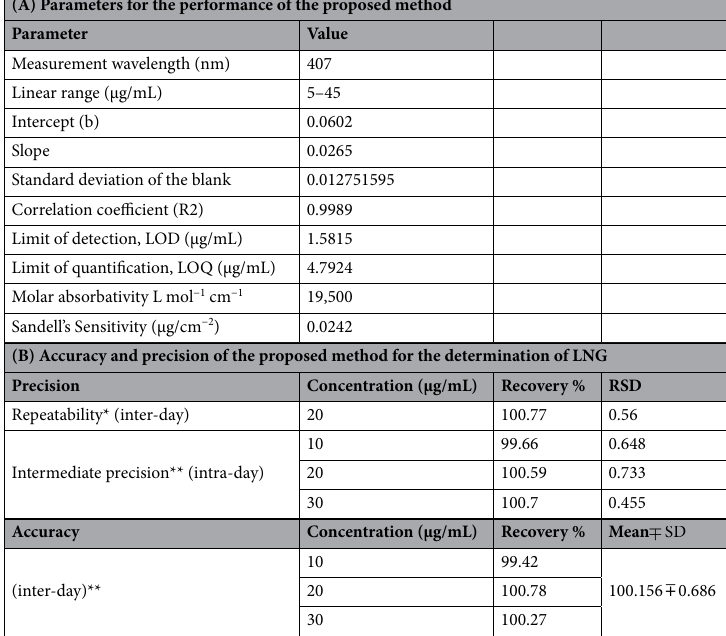
Table 1. Validation of the developed method: (A) Parameters for the performance of the proposed method. (B) Accuracy and precision of the proposed method for the determination of LNG. *Recovery value is mean of 6 replicates; RSD: relative standard deviation. **Recovery values are mean of 3 replicates; SD: standard